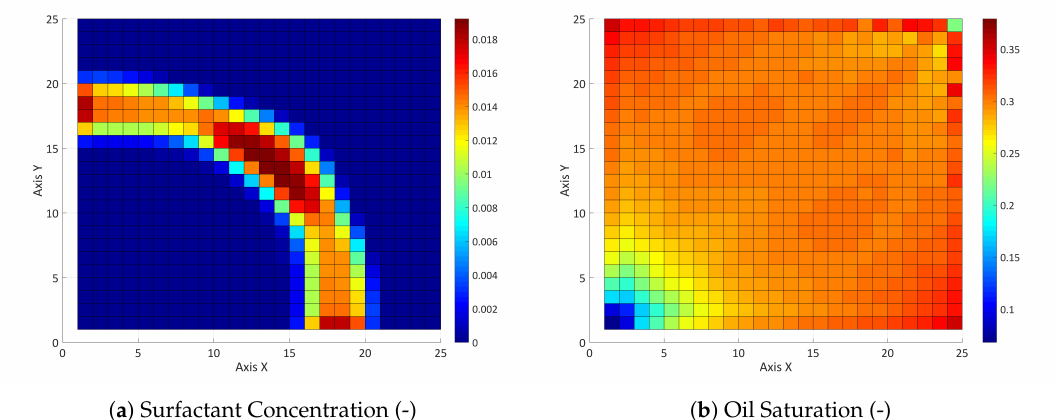
Figure 11. Surfactant concentration (after 1000 days— a ) and oil saturation (after 4000 days— b ) profiles for a cEOR flooding with k c = 0.25, L a pc = 0.5 and L o wc = 1.